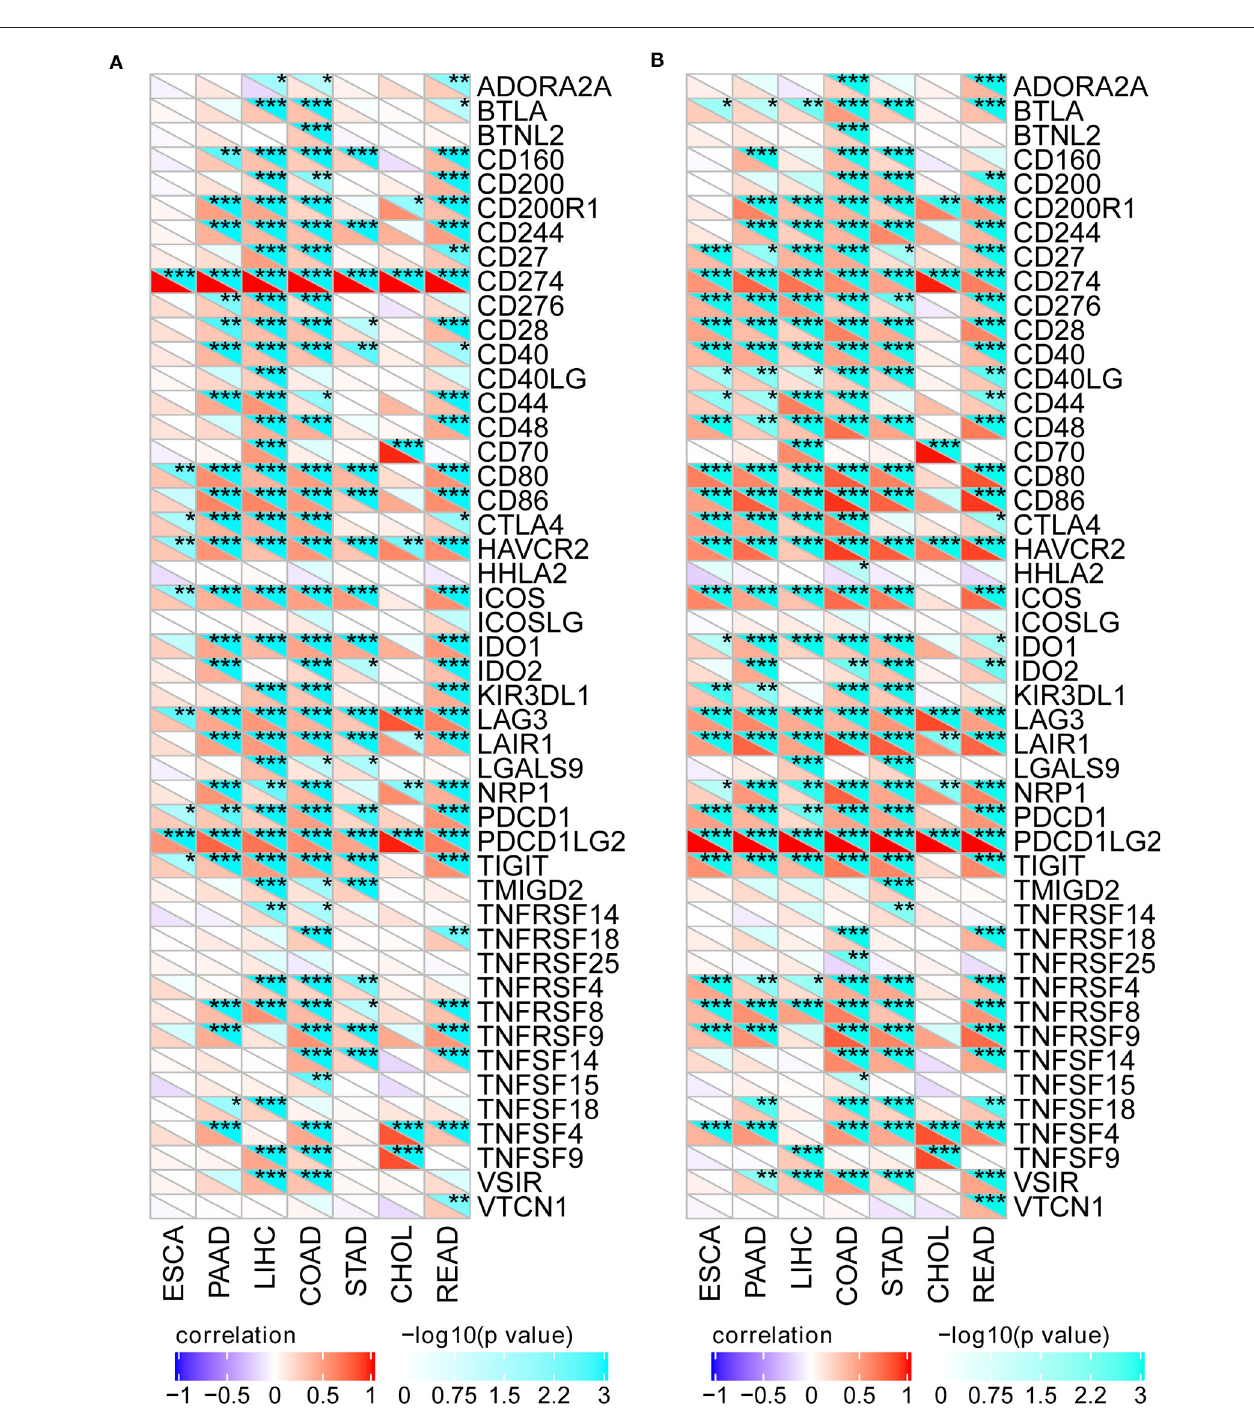
FIGURE 4 | CD274/PDCD1LG2 expression is correlated with immune markers. (A) Heatmap shows that the CD274 expression is correlated with the tumor immune marker level across seven cancers. For each pair, right top triangle is colored representing a p -value; left bottom is colored representing a correlation coefficient. (B) Heatmap shows that the PDCD1LG2 expression is correlated with the tumor immune marker level across seven cancers. * p < 0.05; ** p < 0.01; *** p < 0.001.